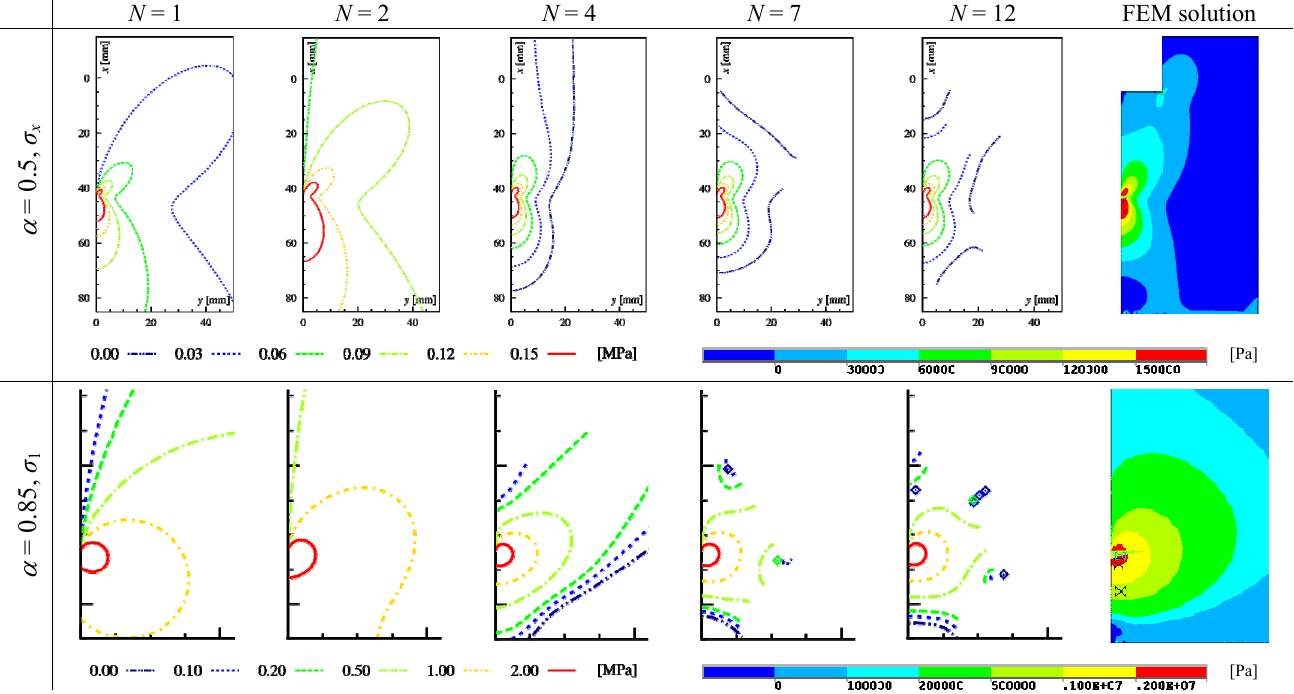
Figure 7: Comparison of stress fields (  x ,  1 ) in WST specimen reconstructed by means of Williams power expansion using various ranges of terms of the series (from left 1, 2, 4, 7, and 12, respectively) with the numerical solution (right). The crack tip region is magnified in the second row (the axes scale is kept the same as in the first